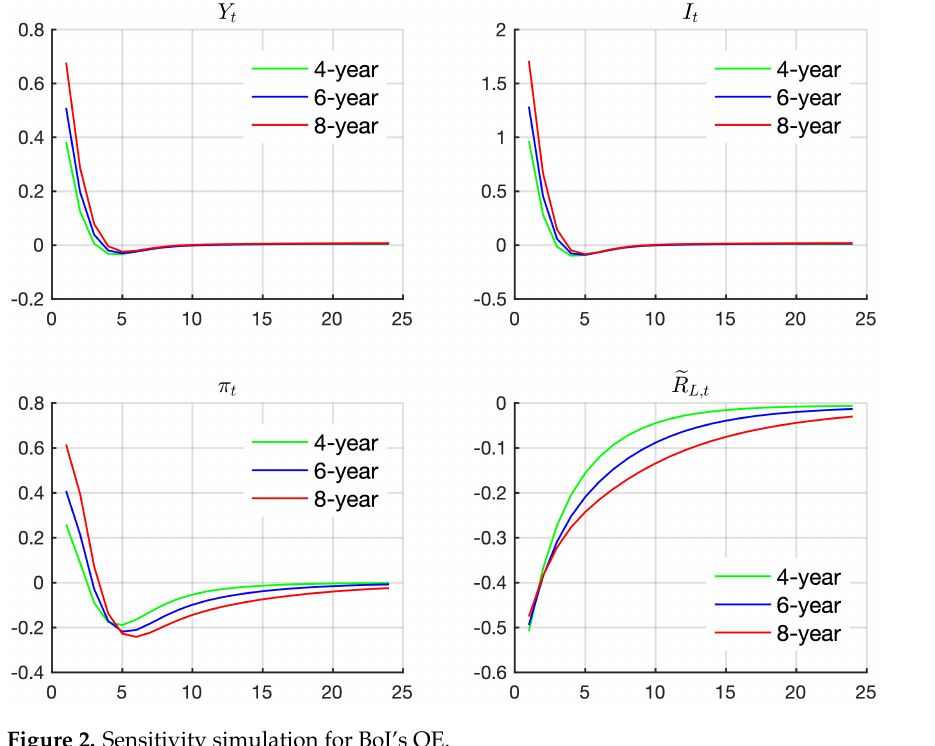
Figure 2. Sensitivity simulation for BoJ’s QE. Table 3. Simulated peak impact of